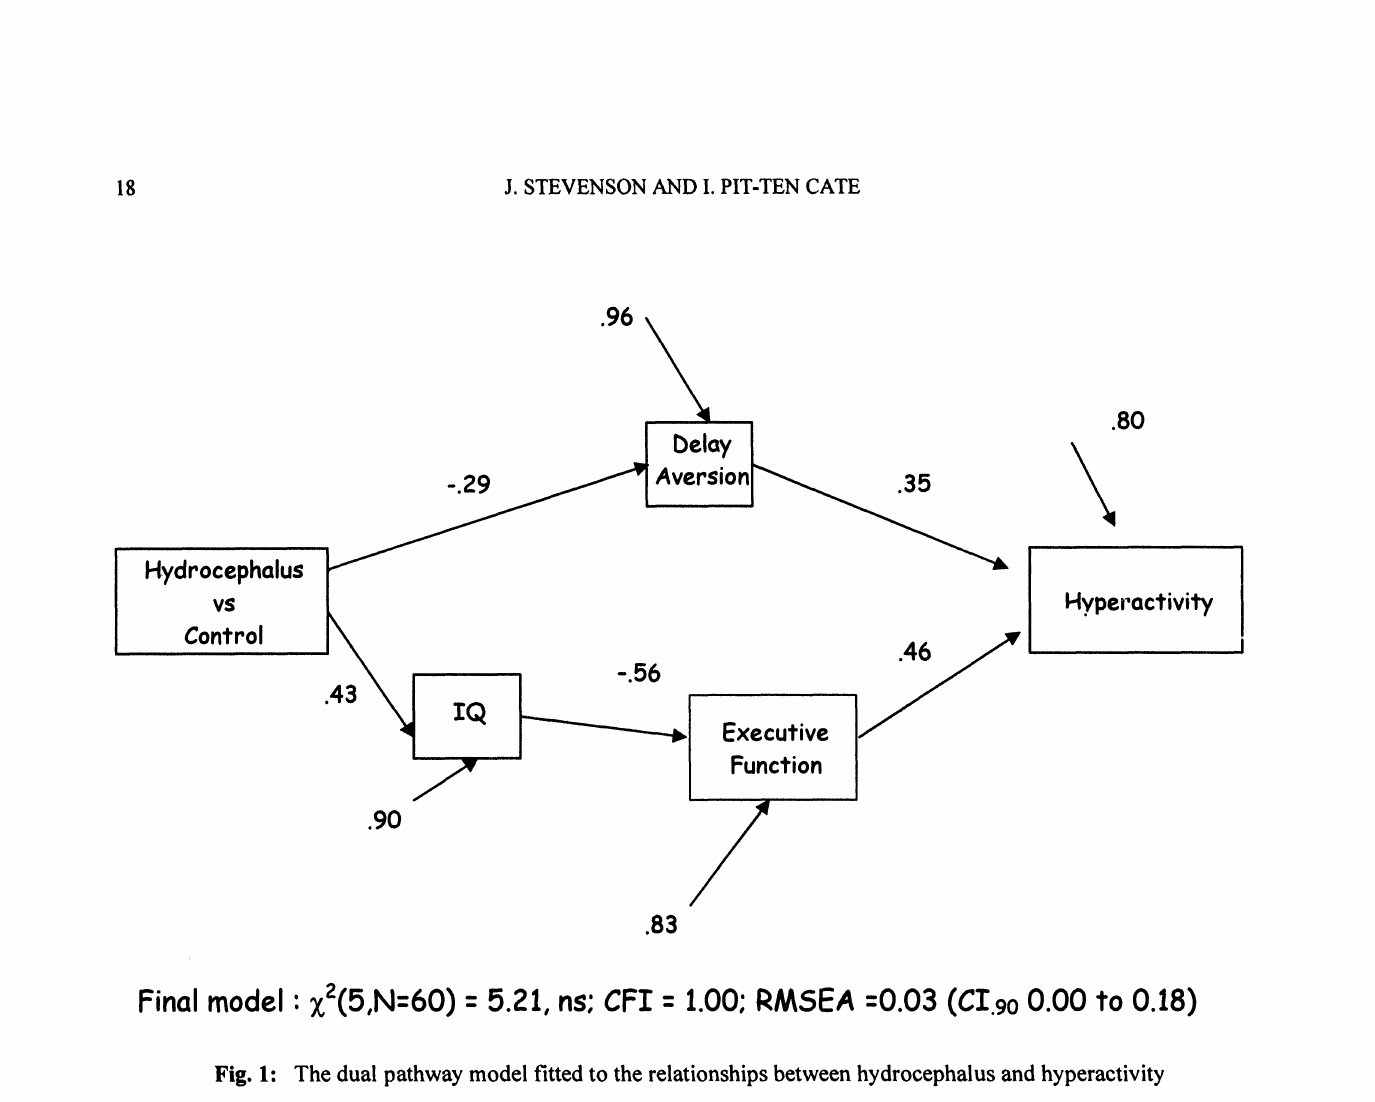
Fig. 1: The dual pathway model fitted to the relationships between hydrocephalus and hyperactivity